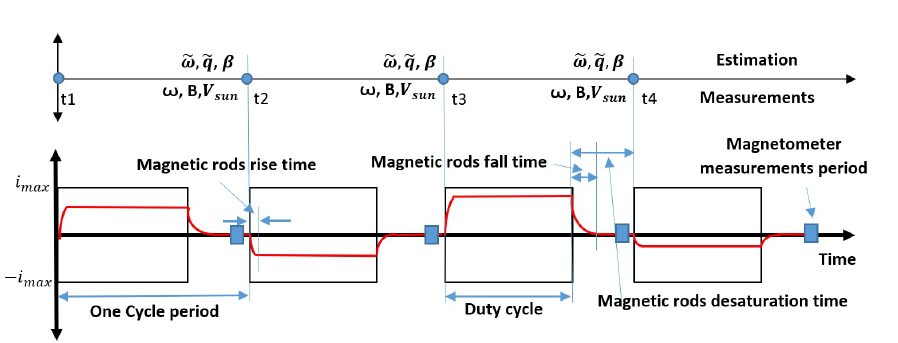
Figure 1. In the reference ADCS algorithm, the magnetic rods operate on a duty cycle principal, alternating with magnetometers to avoid high noise on the